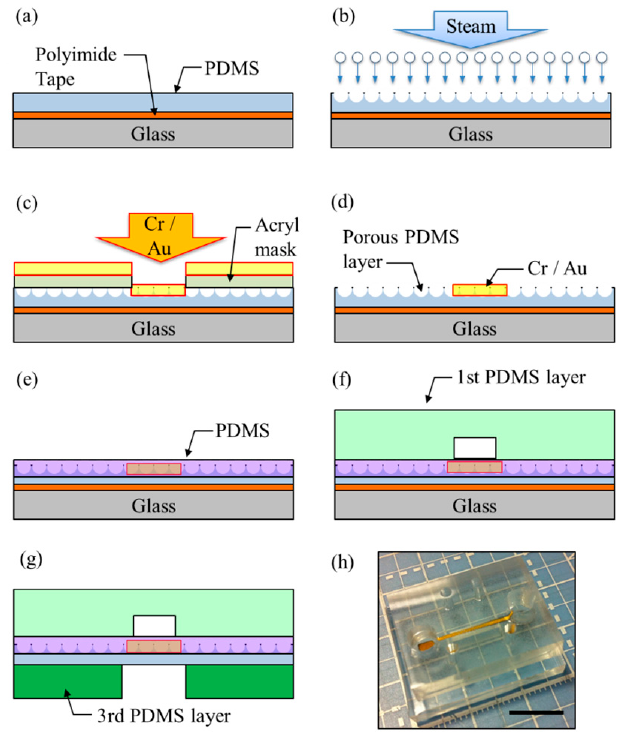
Figure 3. Fabrication procedures: ( a ) PDMS coated by spin coating. ( b ) Uncured PDMS was placed in an autoclave machine for steam etching. ( c ) An acryl mask was used to make a pattern for the electrode. Cr (10 min) and Au (10 min) were sputtered in order. ( d ) After removing the acryl mask, Cr/Au electrode remained on the porous PDMS layer. ( e ) PDMS was coated on the porous PDMS layer to make a surface smooth and protect an electrode. ( f ) The first PDMS layer was bonded on the second PDMS layer to fasten the electrode on the porous PDMS. ( g ) The third PDMS layer was bonded under the second PDMS layer. ( h ) Fabricated microfluidic device. Scale bar marks 1 cm.